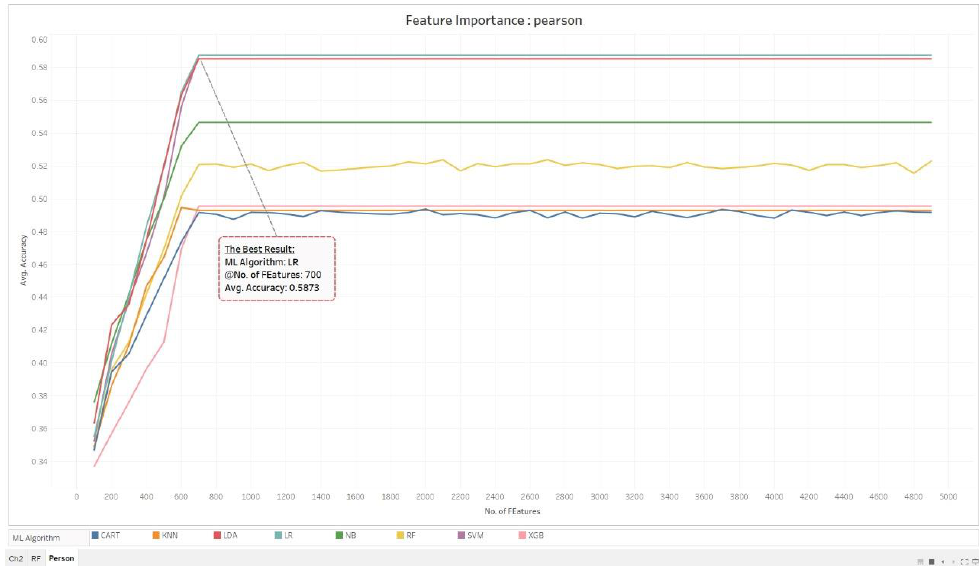
Figure 6. Accuracy of Pearson feature selection method with ML models.